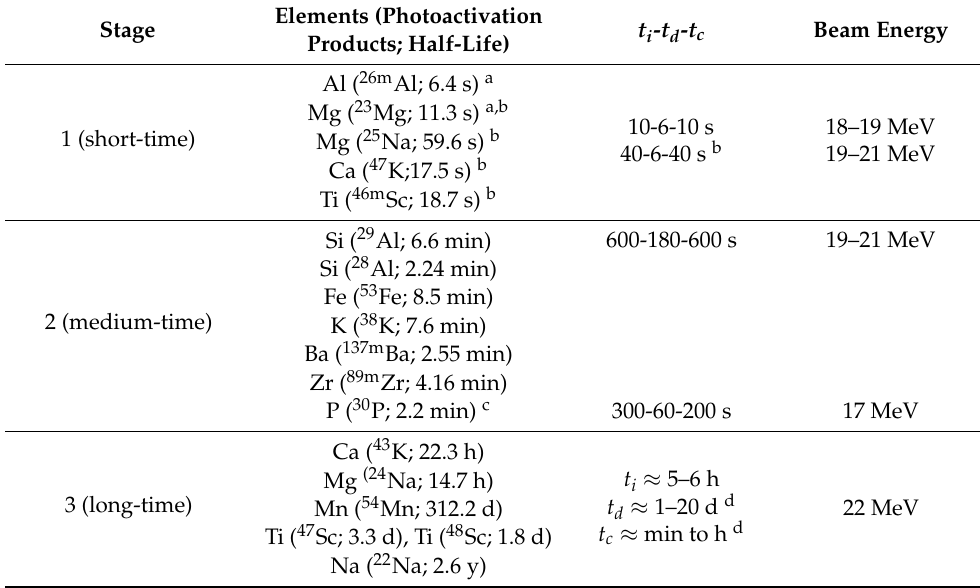
Table 6. Summary of a complete combined IPAA procedure for geochemical major element